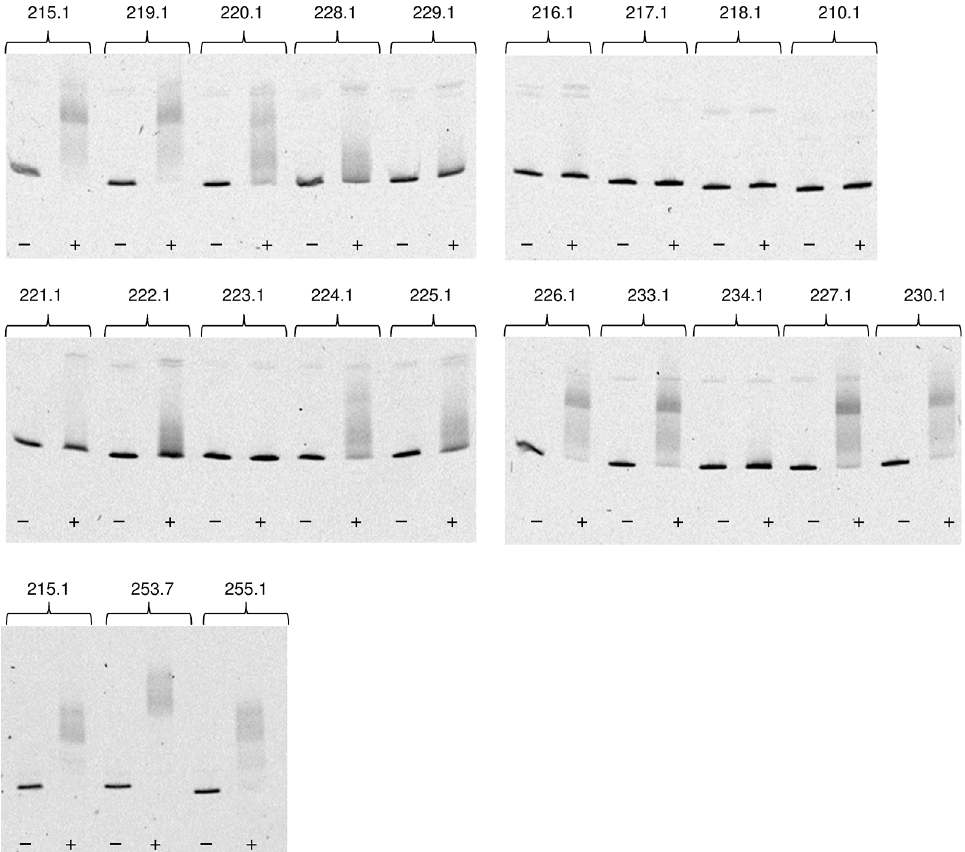
Fig 5. EMSA of 2 nM Cy5-labelled (or 8 nM FITC-labelled) DNA fragments incubated (+) with 445 nM (or 1,780 nM for FITC-labelled fragments) or (-) without MtlR. (A) P mtlE operator mutants with truncated 5 ’ sequences (fragments Cy5-labelled). (B) P mtlE operator mutants with blocks of base substitutions (fragments Cy5-labelled). (C) P mtlE operator mutants with doubled or shifted 15 bp sequence stretch -72 to -58 (fragments FITC-labelled). The numbers of the DNA fragments equal the numbers of the plasmids in Fig